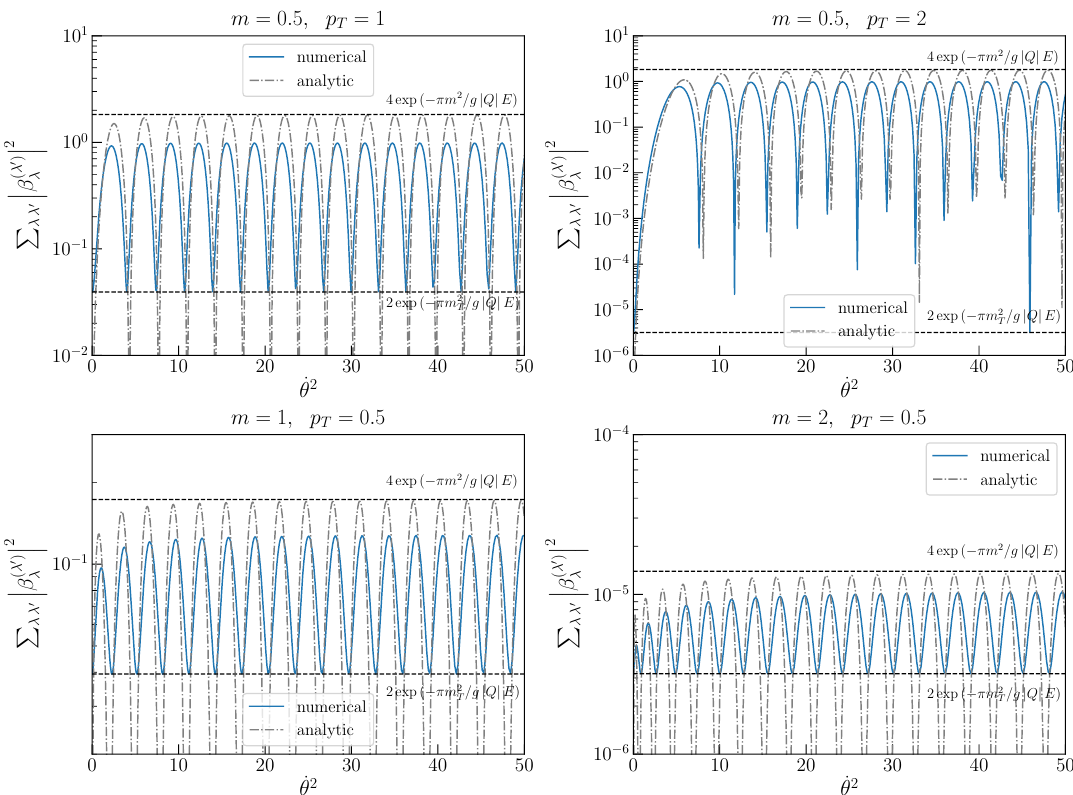
Figure 4 . As figure 3 but with different model parameters, showing the limitations of the analytical expression (D.42) for m 2 , p 2 < g | Q | E . T